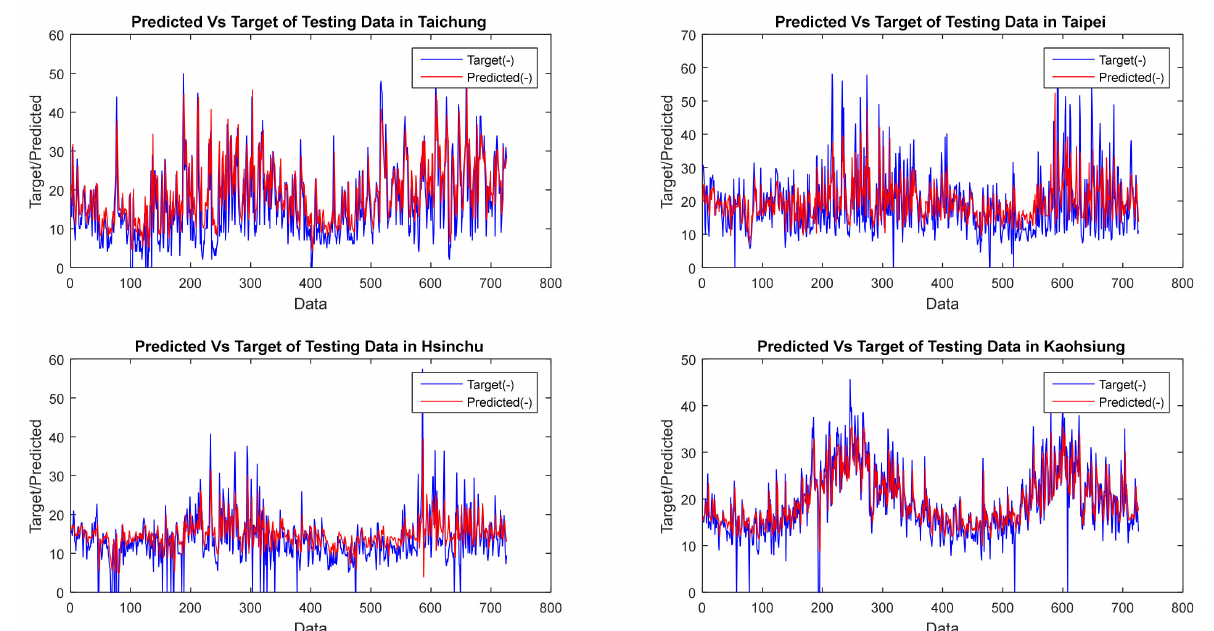
Figure 5. PM 2.5 GSTAR(2) CFNN PSO.